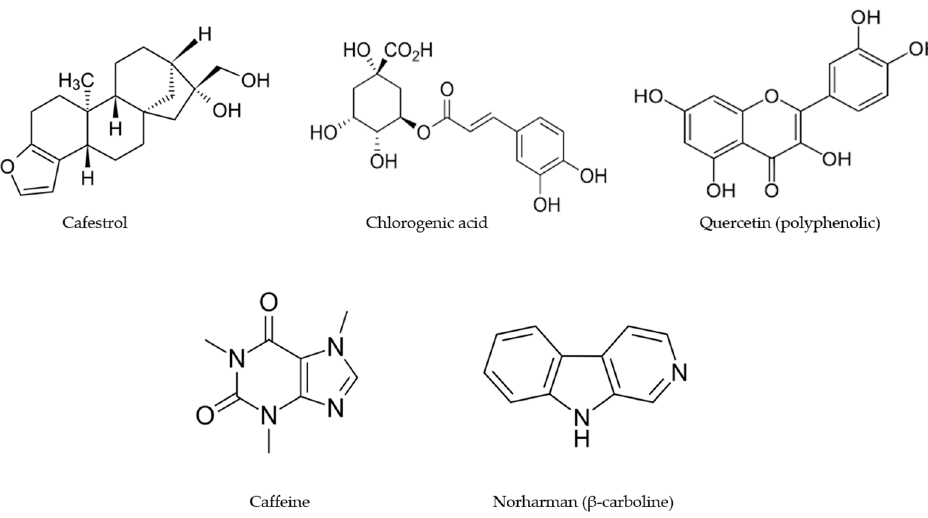
Figure 1. Structures of individual compounds in roasted coffee after extraction with hot water.